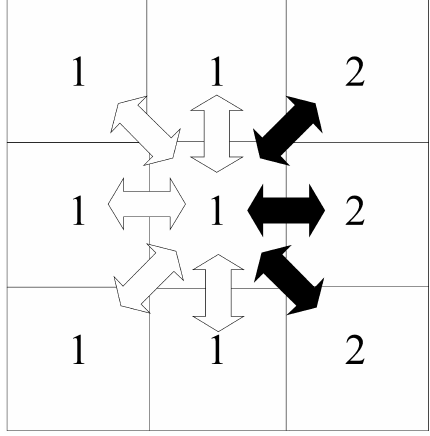
Figure 3. After an attempt of reorientation To Q f = 1, the free energy is reduced to G f = 3. hence the NEW orientation should be maintained.